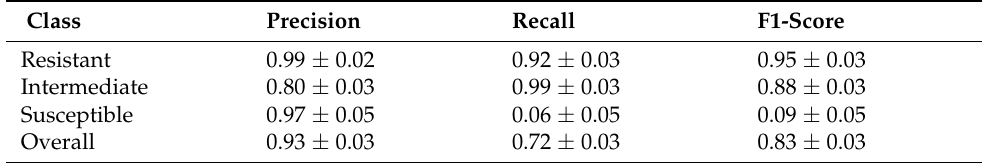
Table 3. Performance (Mean ± SD) during testing using DeepARRNet model trained with the original pea root